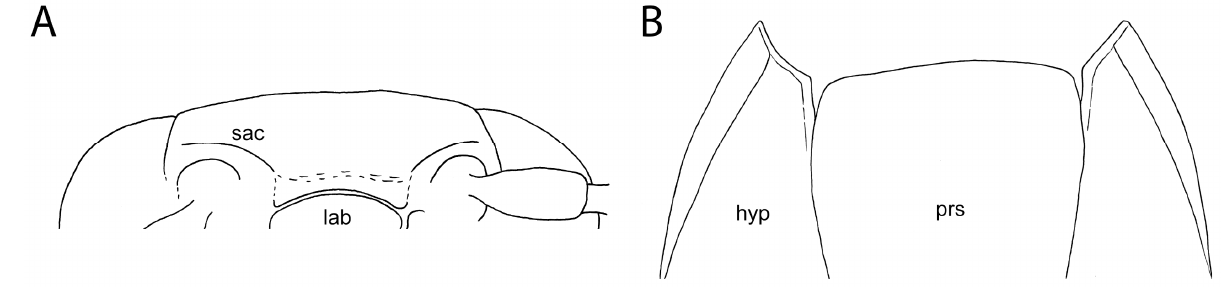
Figure 3. Morphology of Burmogonus cretaceus gen. et sp. nov., drawings. ( A ) Anterior part of head, frontal view; ( B ) anterior portion of prothorax with shortly open pronotosternal sutures, ventral view. lab, labrum; hyp, hypomeron; prs, prosternum; sac, supra-antennal carina. Not to scale. Type species . Burmogonus cretaceus sp. nov., here designated.